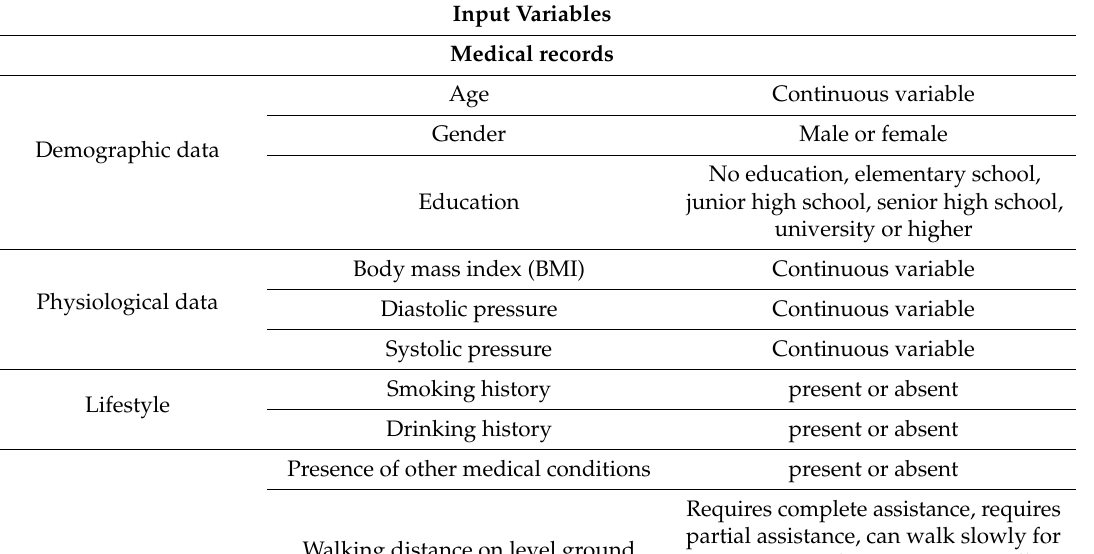
Table 1. Classification of the